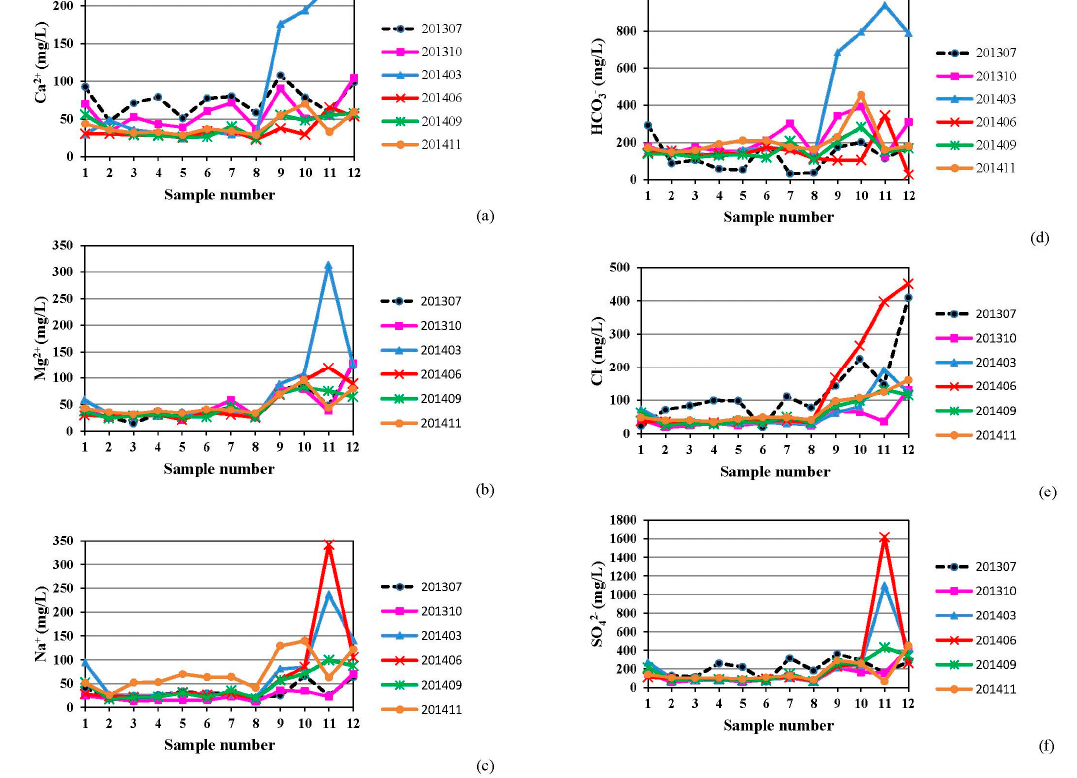
Figure 4. Spatial and temporal variations in the concentrations of: ( a ) Ca 2+ ; ( b ) Mg 2+ ; ( c ) Na + ; ( d ) HCO 3 − ; ( e ) Cl − , and ( f ) SO 42 − ions. See Figure 1 for sample locations.